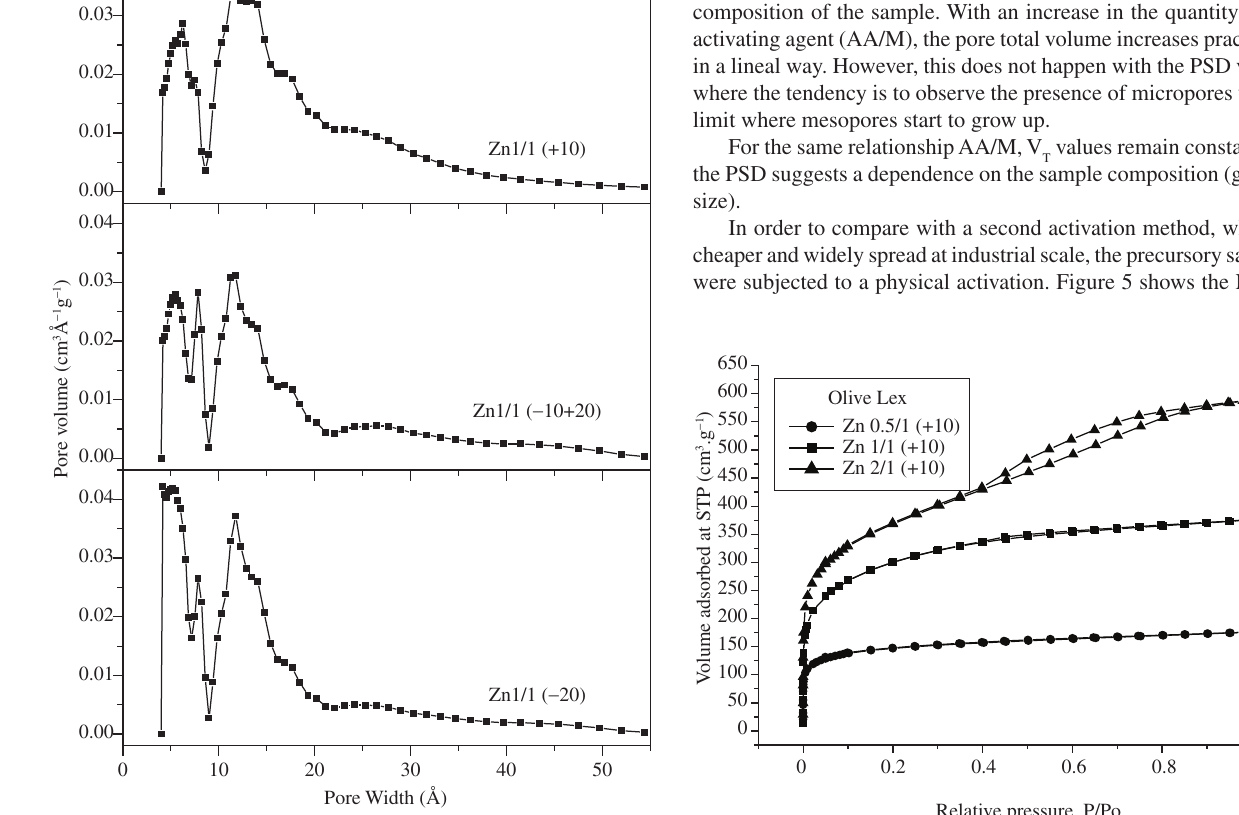
Figure 3. N adsorption-desorption isotherms for the samples sieved at (+10) 2 mesh